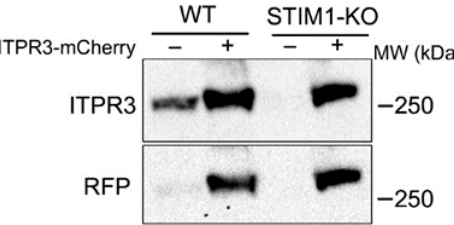
Figure A3. The isolation of mitochondria-associated ER membranes (MAMs), ER, and mitochondria from undifferentiated SH-SY5Y cells revealed that ITPR3 was enriched in MAMs, compared to the bulk ER. As markers to assess the purity of the fractions we studied the level of ACSL4 (MAMs), Grp75, VDAC1, and MCU (mitochondria), and calreticulin (ER).